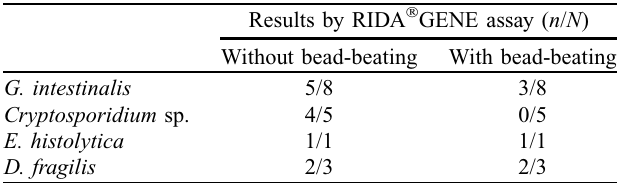
Table 1. Results for tested pre-treatments. Results by RIDA (cid:2) GENE assay ( n / N ) Without bead-beating With bead-beating G. intestinalis 5/8 3/8 Cryptosporidium sp. 4/5